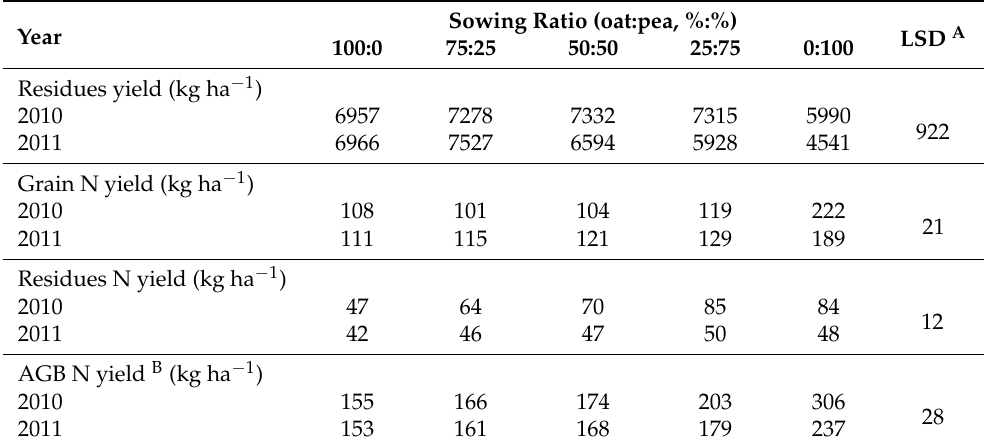
Table 7. Residues yield and N yields of oat and pea pure crop stands and oat:pea intercrops as affected by sowing ratio and